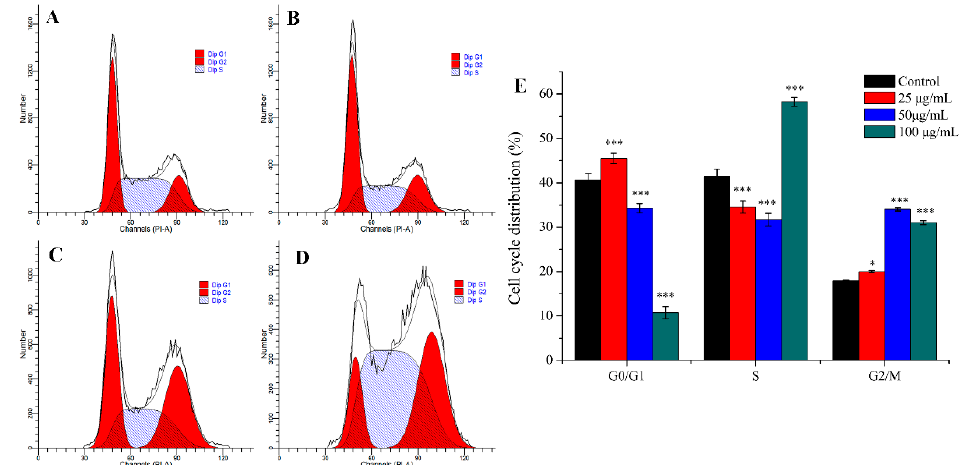
Figure 4. Cell cycle analysis of MGC-803 cells treated by PEO for 24 h. The A–D represented PEO concentrations were 0, 25, 50, and 100 µg/mL, respectively; The E was the numerical histogram of cell cycle distribution (* p < 0.05, *** p < 0.001).